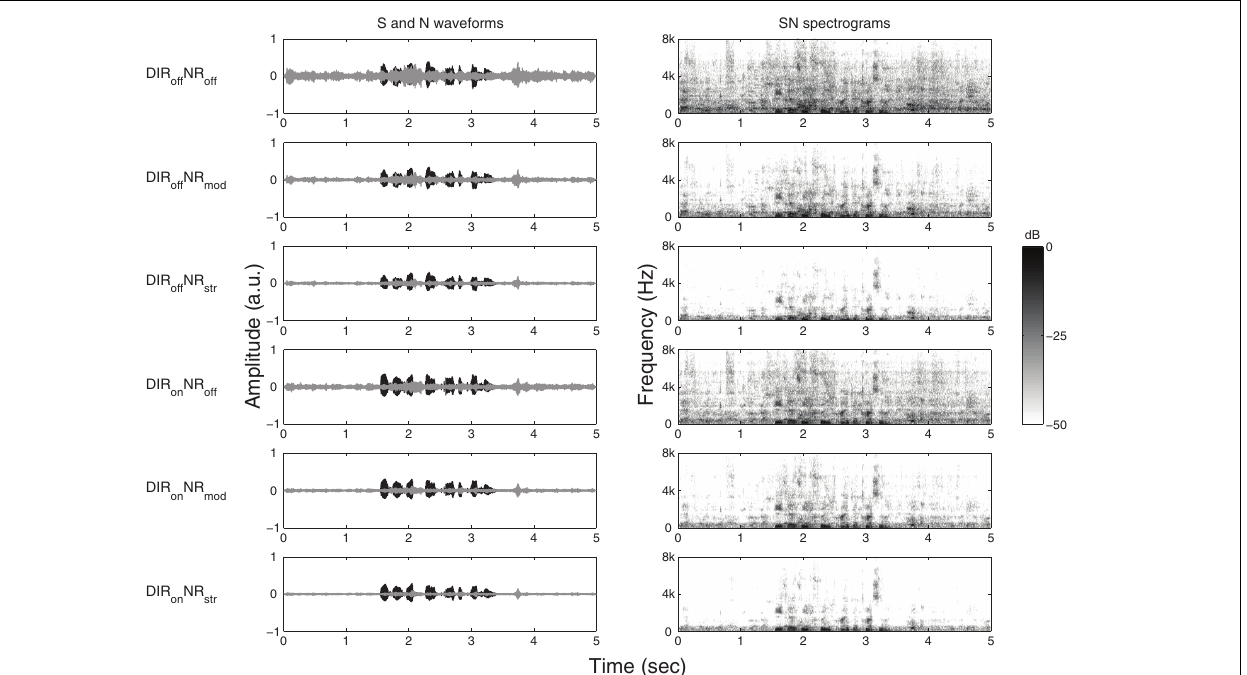
FIGURE 1 | Graphical illustration of the effects of DIR off NR off , DIR off NR mod , DIR off NR str , DIR on NR off , DIR on NR mod , and DIR on NR str processing on (one channel of) an example stimulus with an input SNR of 4dB. Panels on the left-hand side show time